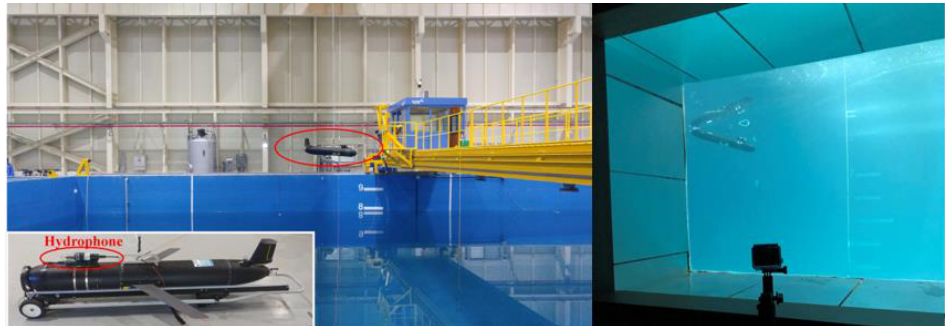
Figure 2. A underwater glider being prepared for immersion into a tank and diving.